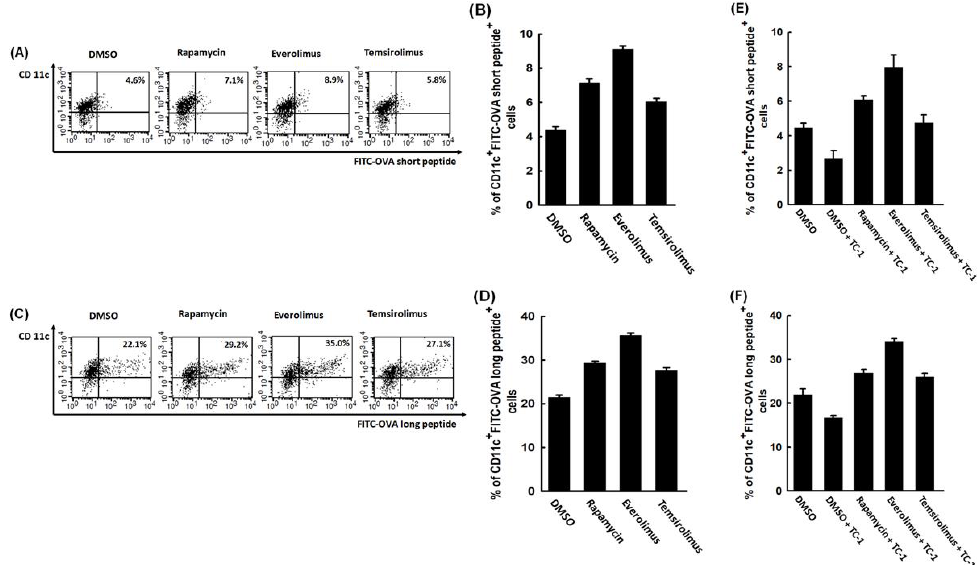
Figure 4. Abilities of antigen presenting and processing of mTORi-treated BMM-derived DCs pulsed with MHC-compatible respective OVA peptide. ( A ) Representative figures of antigen presenting activity of non-mTORi- and mTORi-treated BMM-derived DCs pulsed with FITC-conjugated OVA 257-264 short peptide by flow cytometric analysis. ( n = 3) ( B ) Bar figure of the antigen presenting activity of non-mTORi- and mTORi-treated BMM-derived DCs pulsed with FITC-conjugated OVA short peptide. The abilities of antigen presenting were higher in mTORi-treated BMM-derived DCs than non-mTORi-treated group ( p = 0.017, n = 3) ( C ) Representative figures of antigen processing activity of non-mTORi- and mTORi-treated BMM-derived DCs pulsed with FITC-conjugated OVA 323-339 long peptide by flow cytometric analysis. ( n = 3) ( D ) Bar figure of the antigen processing activity of non-mTORi- and mTORi-treated BMM-derived DCs pulsed with FITC-conjugated OVA long peptide. The abilities of antigen processing were higher in mTORi-treated BMM-derived DCs than non-mTORi-treated group ( p = 0.013, n = 3) ( E ) Bar figure of the antigen presenting activity of non-mTORi- and mTORi-treated BMM-derived DCs co-cultured with TC-1 tumor cells and then pulsed with FITC-conjugated OVA short peptide. The abilities of antigen presenting of non-mTORi-treated BMM-derived DCs co-cultured with TC-1 tumor cells and then pulsed with FITC-conjugated OVA short peptide would be lower than those only pulsed with FITC-conjugated OVA short peptide ( p = 0.043, n = 3). The abilities of antigen presenting of mTORi-treated BMM-derived DCs co-cultured with TC-1 tumor cells and then pulsed with FITC-conjugated OVA short peptide were still better than those of non-mTORi-treated BMM-derived DCs only pulsed with FITC-conjugated OVA short peptide ( p = 0.023, n = 3). ( F ) Bar figure of the antigen processing activity of non-mTORi- and mTORi-treated BMM-derived DCs co-cultured with TC-1 tumor cells and then pulsed with FITC-conjugated OVA long peptide. The abilities of antigen processing of non-mTORi-treated BMM-derived DCs co-cultured with TC-1 tumor cells and then pulsed with FITC-conjugated OVA long peptide would be lower than those only pulsed with FITC-conjugated OVA long peptide ( p = 0.048, n = 3). The abilities of antigen processing of mTORi-treated BMM-derived DCs co-cultured with TC-1 tumor cells and then pulsed with FITC-conjugated OVA long peptide were still better than those of non-mTORi-treated BMM-derived DCs only pulsed with FITC-conjugated OVA long peptide ( p = 0.012, n =